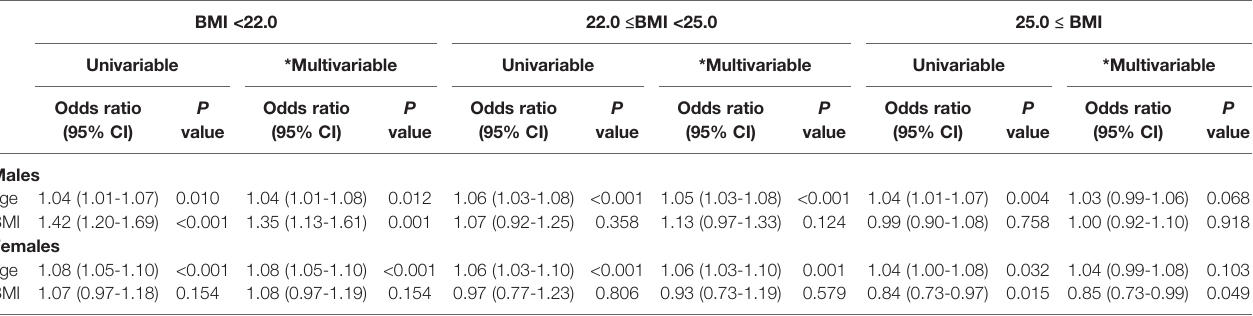
TABLE 4 | Logistic multivariable regression analysis for High adiponectin and High HOMA-R in 5,673 subjects (3,467 males and 2,206 females) strati fi ed by body mass index. BMI